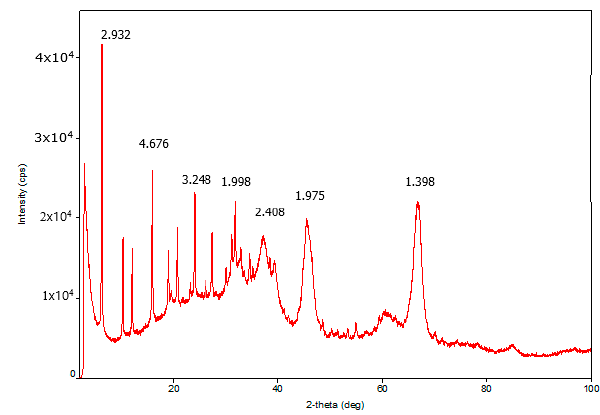
Figure 1. XRD pattern of granular catalyst.